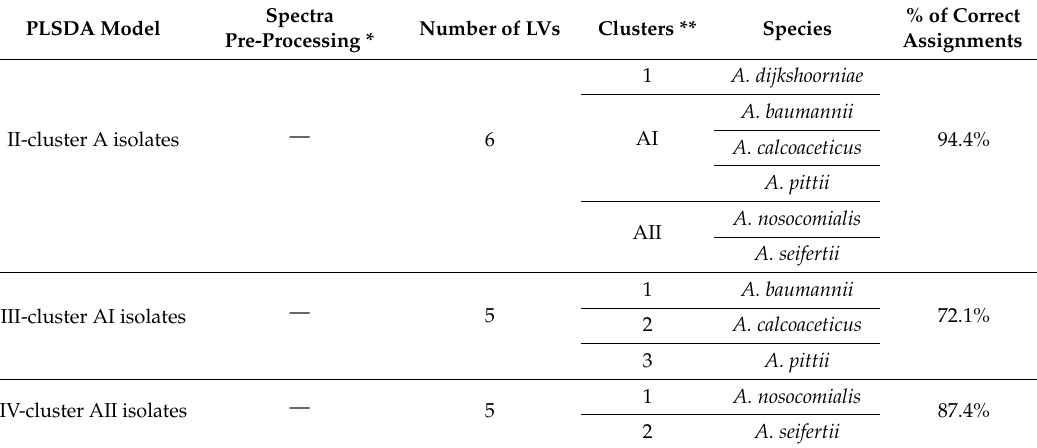
Table 2. Details of PLSDA models developed for Cluster A Acinetobacter species